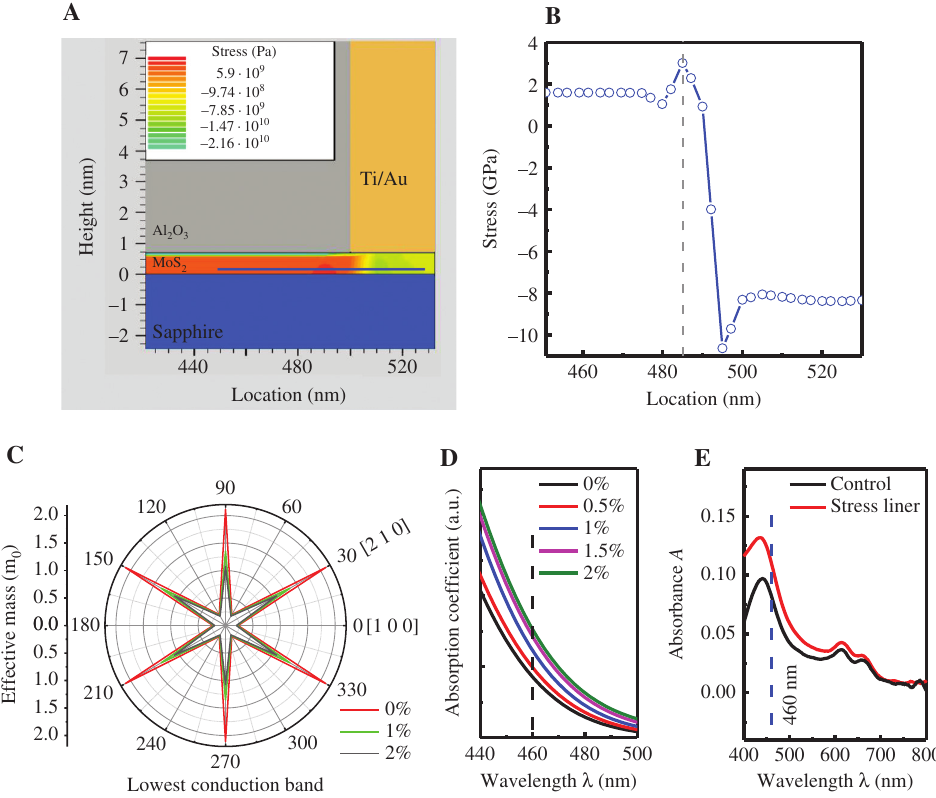
with and without stress liner. Figure 2: Stress analysis of MoS 2 (A) 2D stress mapping within the monolayer MoS photodetector with the Al O stress liner. (B) Horizontal stress distribution within the 2 2 3 monolayer MoS layer. (C) Tensile strain enables significant reduction of the effectivemass of monolayer MoS . (D) Calculated absorption 2 2 coefficient as a function of wavelength under 0–2% tensile strain. (E) Measured absorbance A of control and stress liner samples as a function of the incident wavelength. There are three excitonic absorption peaks (A, B, and C) between 400 and 700 nm in the MoS 2 absorbance curve. The overall absorbance value of the sample with Al O is higher than that without 2 3